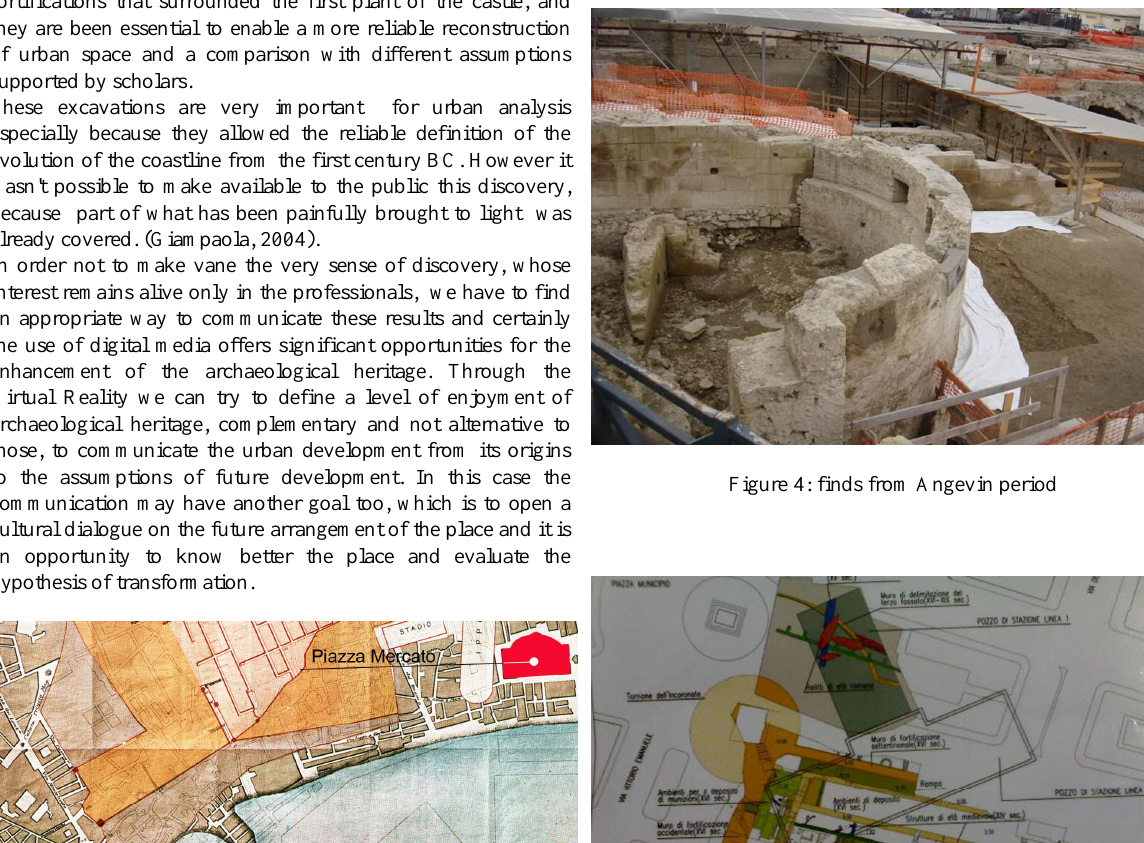
Figure 5: plan of archaeological finds related to underground